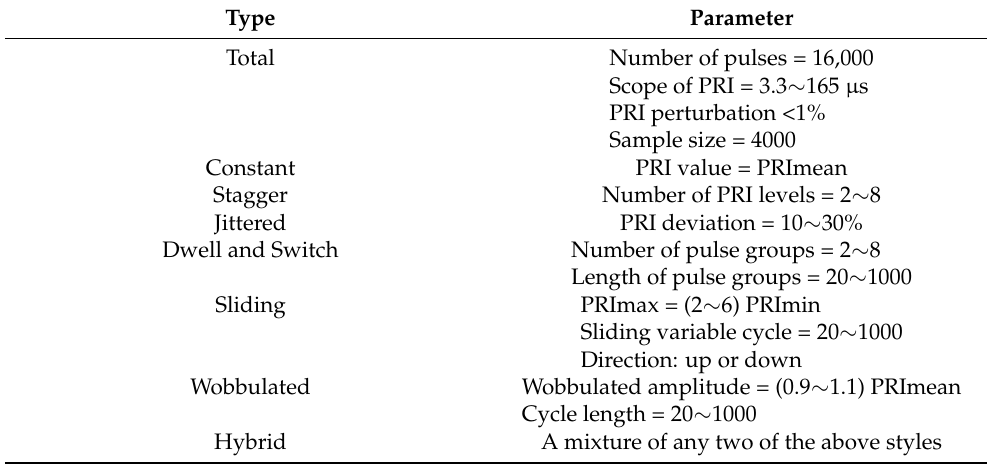
Table 2. RPDWS-I dataset. The dataset contains six conventional modulation styles and randomly mixed modulation styles, and each pulse sequence is randomly combined from a given range.